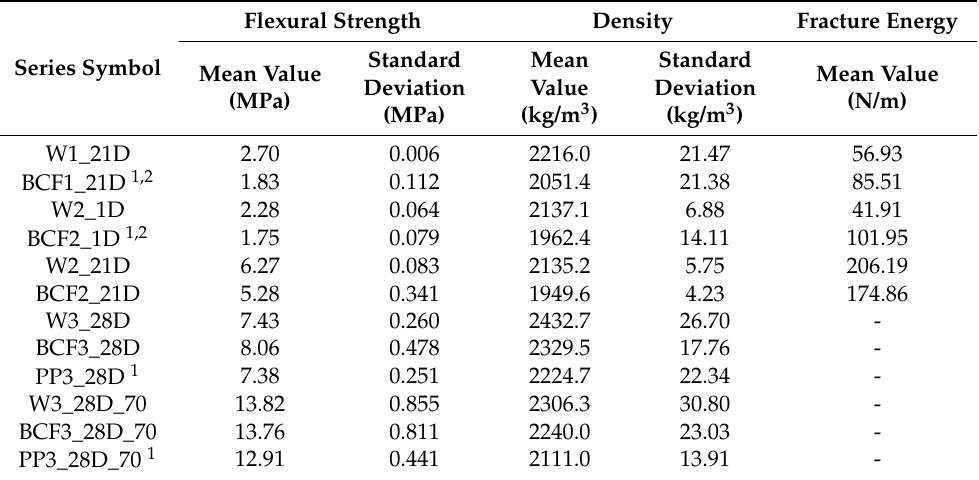
Table 6. Summary of all the results from this research programme: flexural strength and density of mortars and occurrence of bridging effect. Flexural Strength Series Symbol